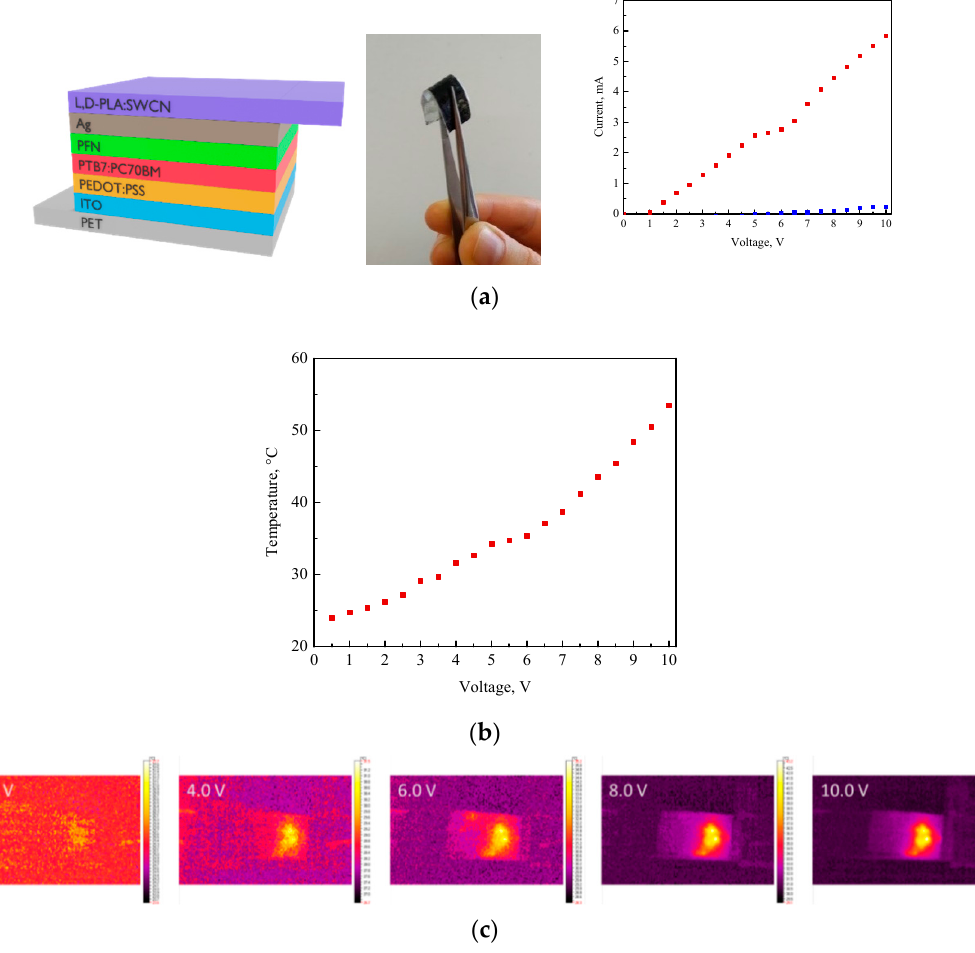
Figure 10. The architecture and photo of the created device and the summary of the thermal Figure10. Thearchitectureandphotoofthecreateddeviceandthesummaryofthethermalexperimentsfora experiments for a device composed of PET/ITO/PTB7:PC 70 BM/PFN/Ag/L,D-PLA:SWCN (10:0.5) (red device composed of PET / ITO / PTB7:PC 70 BM / PFN / Ag / L,D-PLA:SWCN (10:0.5) (red symbols): ( a ) correlation symbols): ( a ) correlation of the current versus applied potential (blue symbols for film LD-PLA:SWCN of the current versus applied potential (blue symbols for film LD-PLA:SWCN (10:0.5)); ( b ) correlation of (10:0.5)); ( b ) correlation of temperature versus applied potential; ( c ) thermal images for devices at 2, temperature versus applied potential; ( c ) thermal images for devices at 2, 4, 6, 8, and 10 4, 6, 8, and 10 V.